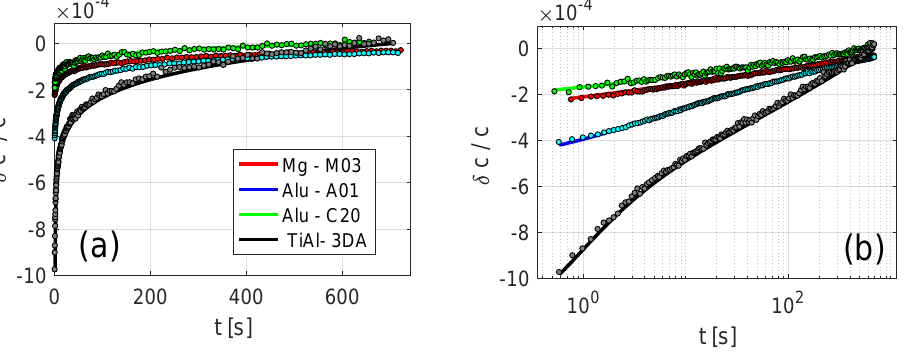
Figure 6. Fitting of experimental data using a continuous Weibull distribution of relaxation times for different samples. ( a ) Linear scale; ( b ) log time